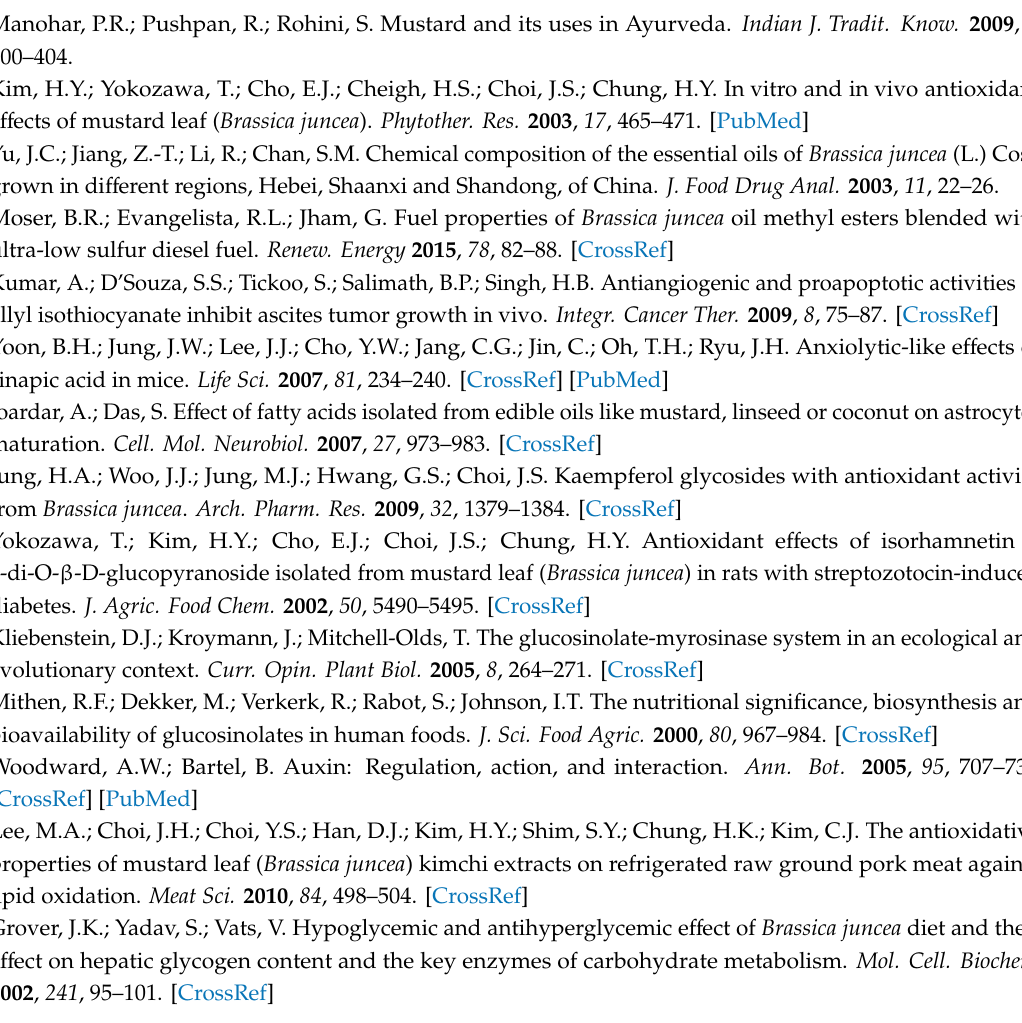
Figure S1. Brassica juncea sprouts grown under di ff erent light-emitting diode (LED) lights (blue, white, and red) for three weeks., Figure S2. Spectral distribution of the white LED, Figure S3. Chromatogram of the phenolic compounds (A) and the desulfo-glucosinolates (B) extracted from mustard sprouts grown under blue LED lights. 1, Gallic acid; 2, catechin; 3, chlorogenic acid; 4, 4-hydroxybenzoic acid; 5, ca ff eic acid; 6, sinapic acid; 7, quercetin; 8, glucoiberin; 9, sinigrin; 10, gluconapin; 11, 4-hydroxyglucobrassicin; 12, glucobrassicin; 13, 4-methoxyglucobrassicin; 14, gluconasturtiin; 15, neoglucobrassicin., Figure S4. Two-way ANOVA interaction plots showing changes in means of phenolic contents by developmental time and light sources., Figure S5. Two-way ANOVA interaction plots showing changes in means of glucosinoalte contents by developmental time and light